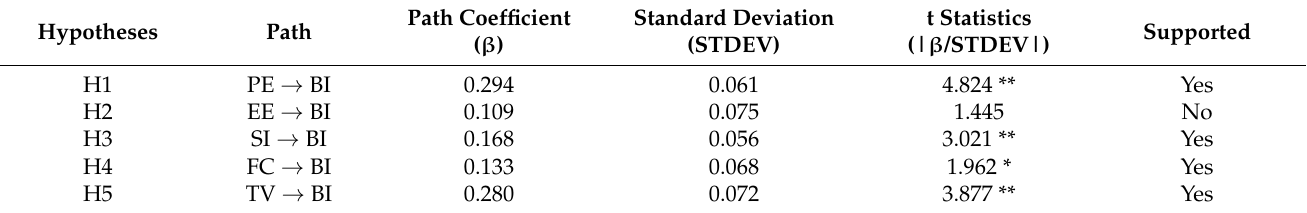
Table 5. Structural model assessment.